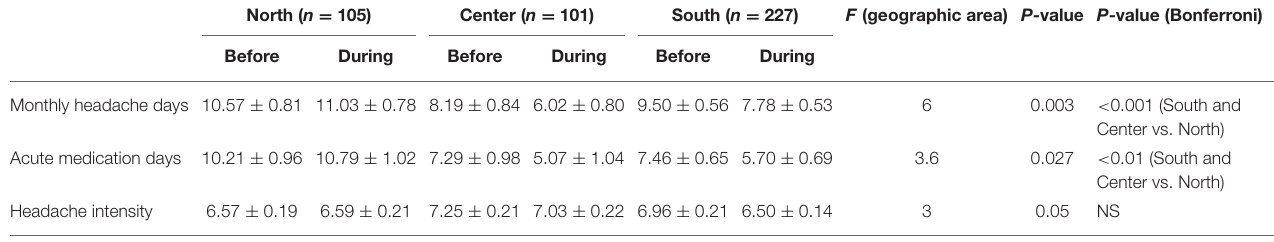
TABLE 3 | Comparison of headache features before and during lockdown period in the included patients. North ( n = 105) Center ( n = 101) South ( n = 227) F (geographic area) P -value P -value (Bonferroni) Before During Before During Before During